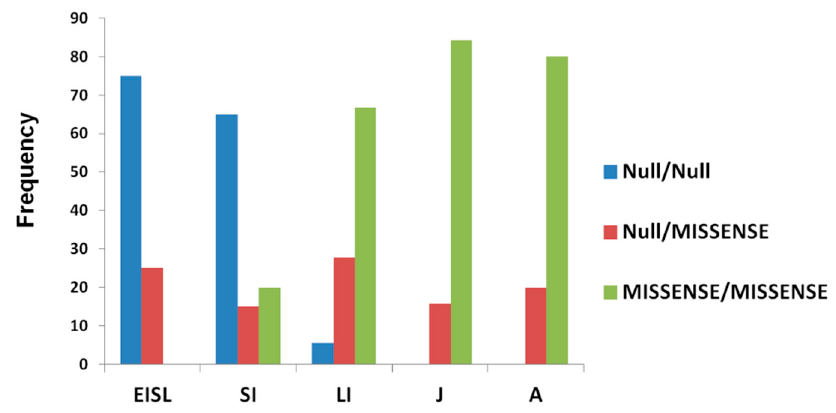
Figure 6. Distribution of genotypes among NPC phenotypes. Genotypes were categorized as homozygote (null / null) or compound heterozygote (null / missense) for severe mutations and homozygote for a missense mutation (missense / missense). 75% and 65% of EISL (early infantile systemic lethal) and SI (severe infantile) patients, respectively, were homozygote for severe mutations, while 66.7% of LI (Late infantile) 84.2% of J (juvenile) , and 80% of A (adult) patients presented missense mutations in both alleles. No homozygote or compound heterozygote for severe mutations was detected in J or A patients.